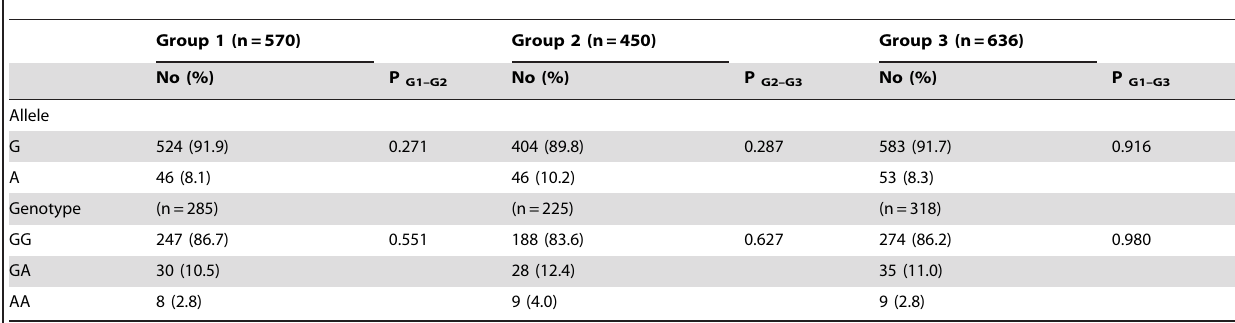
Table 2. Allele and Genotype distribution in different